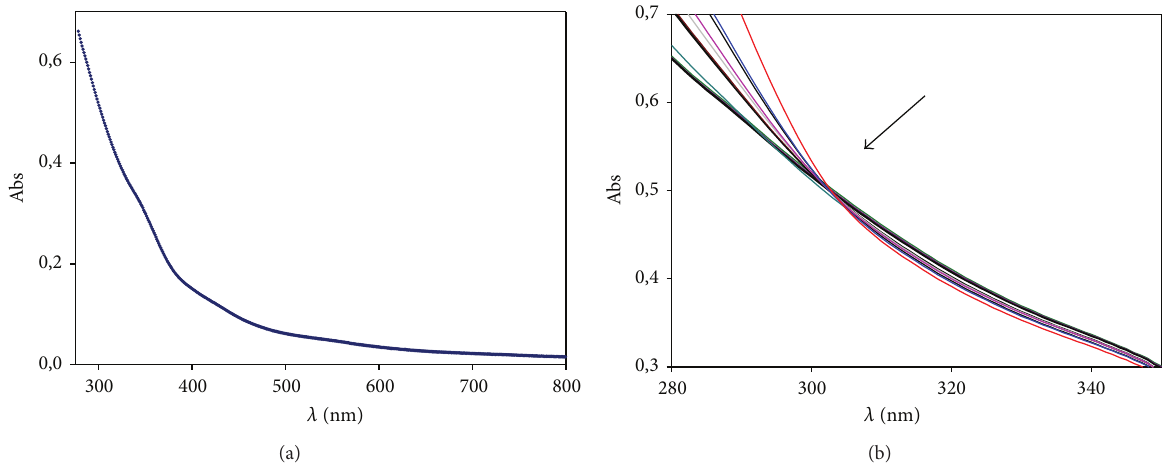
Figure 2: (a) Absorption spectrum of the Au@tiopronin. (b) Absorbance titration of AuNPs/DNA system recorded for increasing concentrations of DNA. [AuNPs] = 1.58 × 10 −6 M; [DNA] = 0M (top); [DNA] = 1 × 10 −4 M